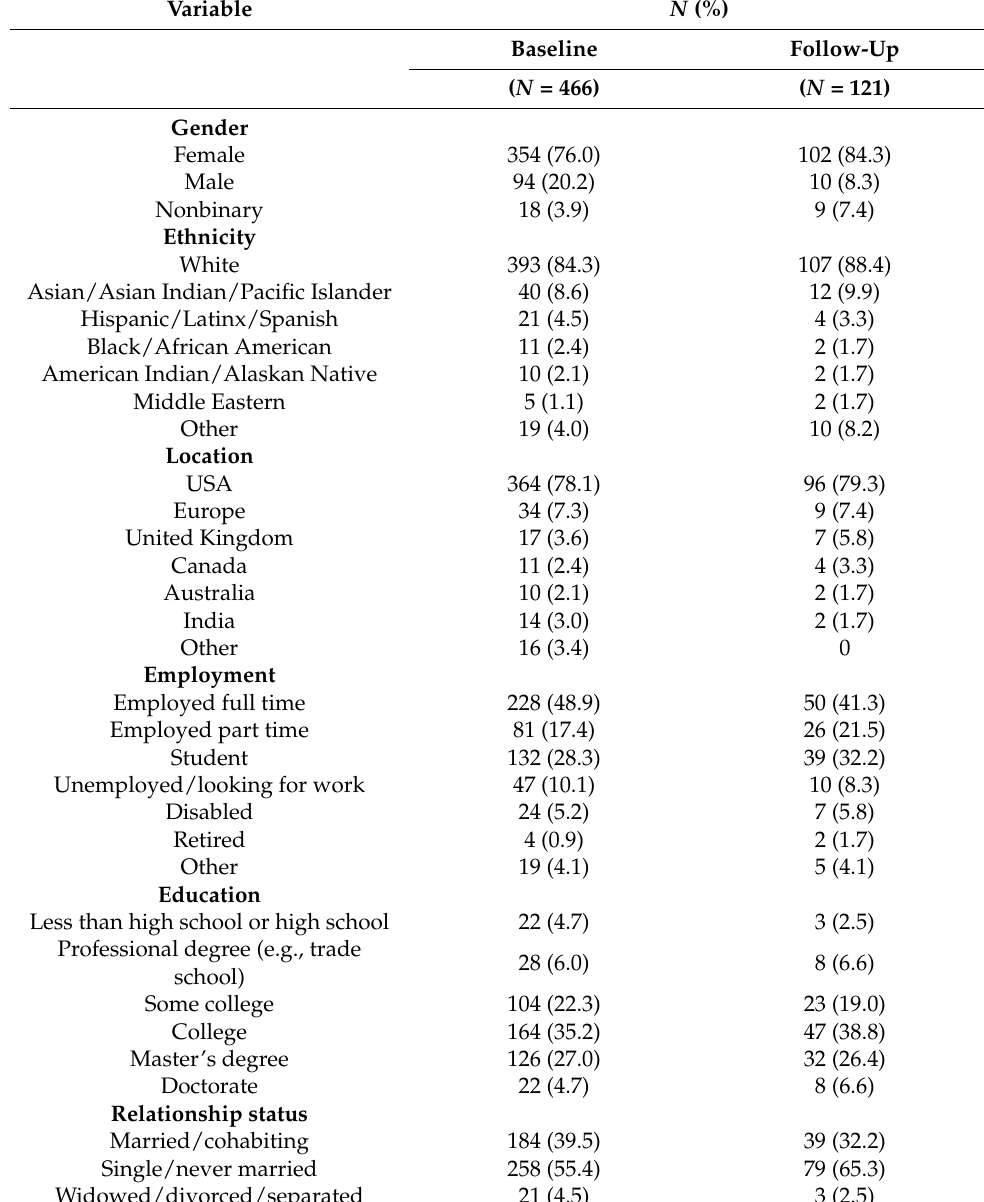
Table 1. Patients’ Characteristics ( N =